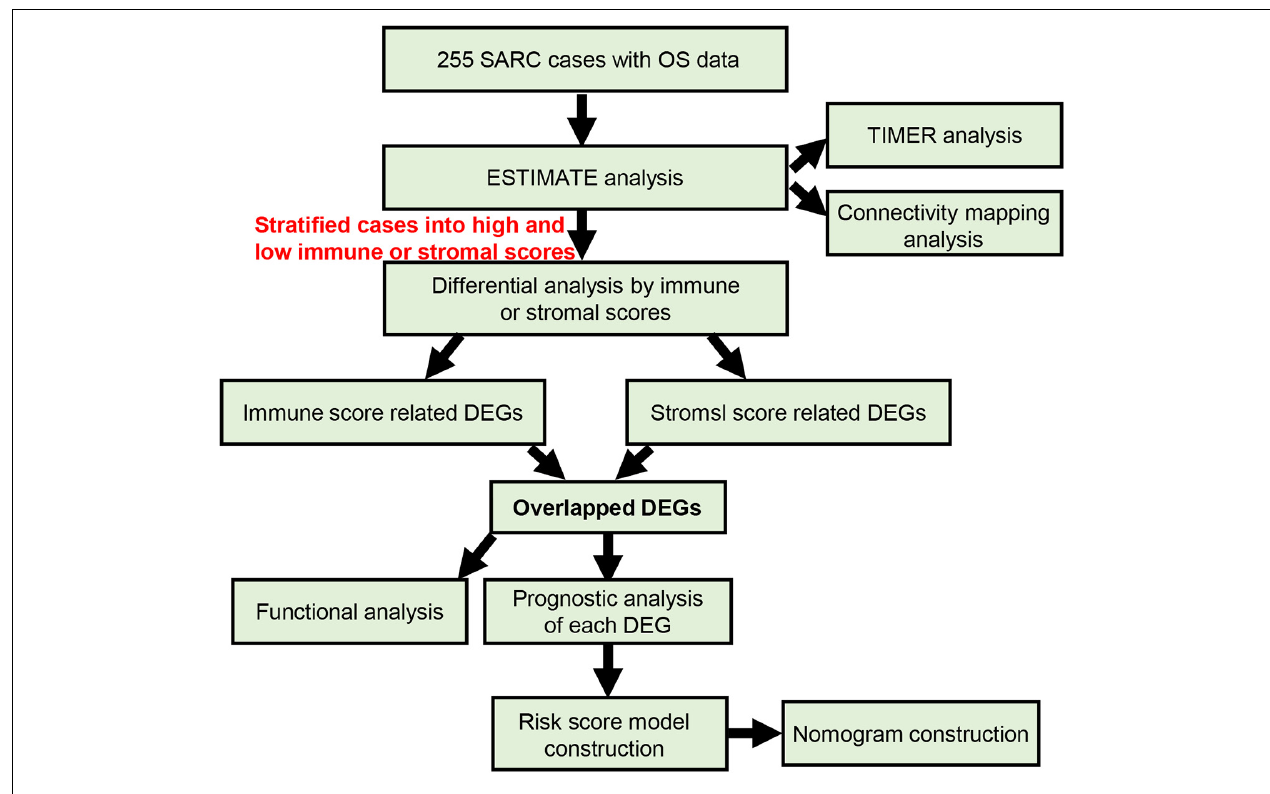
FIGURE 1 | The flow chart of current study.